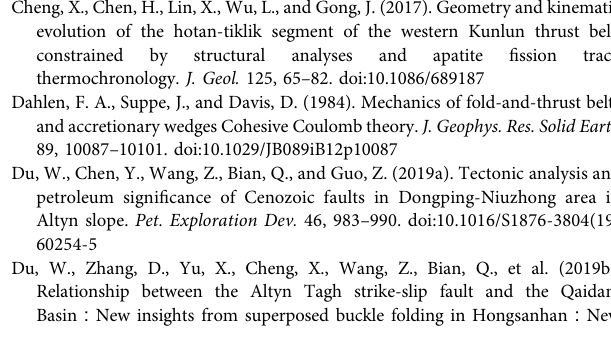
Frontiers in Earth Science |